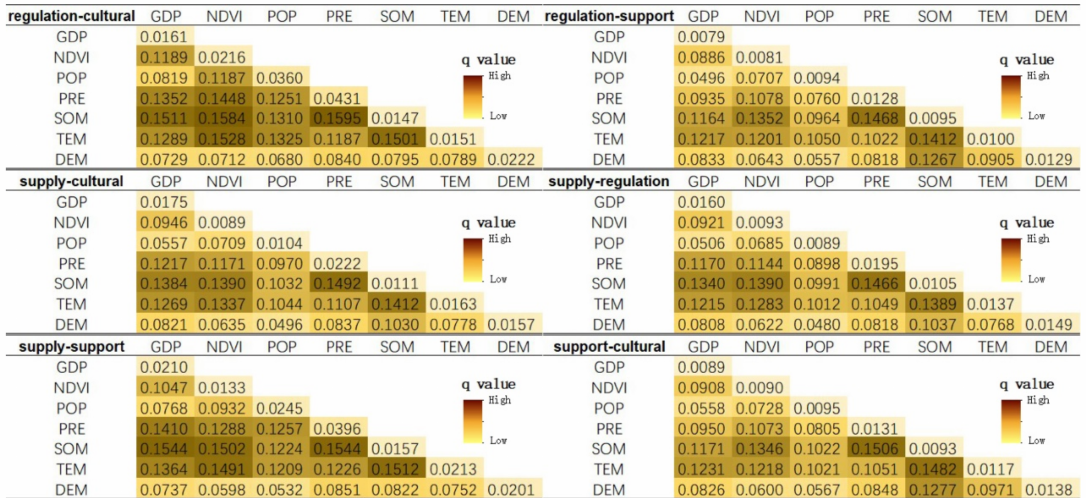
Figure 8. The impact of single-factor and two-factor interaction on the trade-offs and